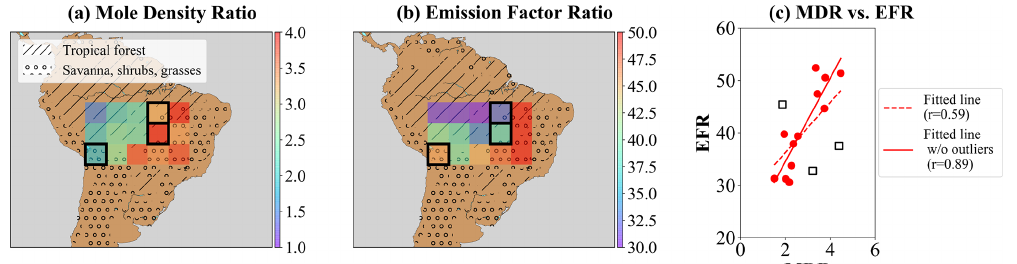
Figure 11. In panel (a) the spatial pattern of the September average MDR determined with TROPOMI for 15 5 ◦ × 5 ◦ regions using the SBM. In panel (b) for the same 15 regions the spatial pattern of the September average EFR determined from the ratio between NO x and CO emissions from GFED4s. Panel (c) shows the relationship between the 15 MDR and EFR estimates, including the dashed linear regression line and the Pearson correlation coefficient. The three largest outliers are identified with a black square symbol and are highlighted by the black frames in panels (a) and (b) . The linear regression line without the outliers is shown by the solid line in panel (c)